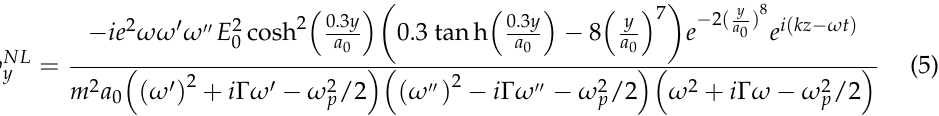
Figure 3. Variation of ponderomotive force with transverse distance from the beam axis for different values of incident lasers electric field, when 𝜔 ′ = 1.884 × 10 14 rad/s, 𝜔 ′′ = 1.811 × 10 14 rad/s, ℎ 𝑛𝑐 = 5𝑟 𝑛𝑐 and 𝑑 𝑛𝑐 = 6𝑟 𝑛𝑐 of the nanocylinders.